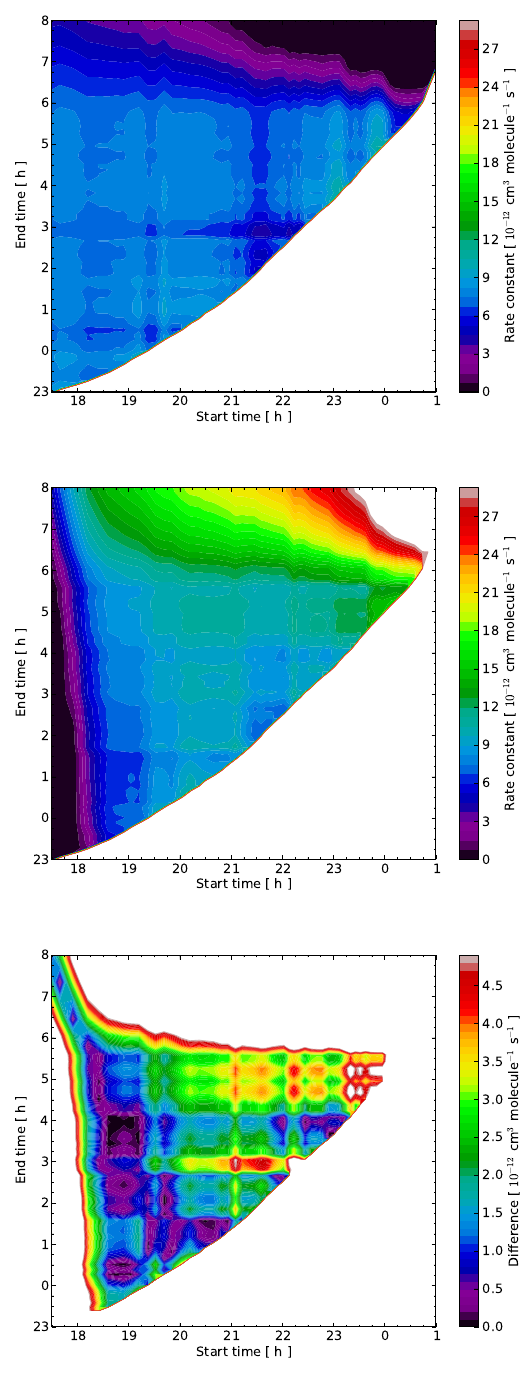
Fig. 3. Contour plots of c k 1 (top), c k 0 (middle), and 1k (bottom) 1 calculated from the SMILES observation data set. c k 1 and c k 0 are calculated in time periods from each start time (horizontal axis) to each end time (vertical axis).